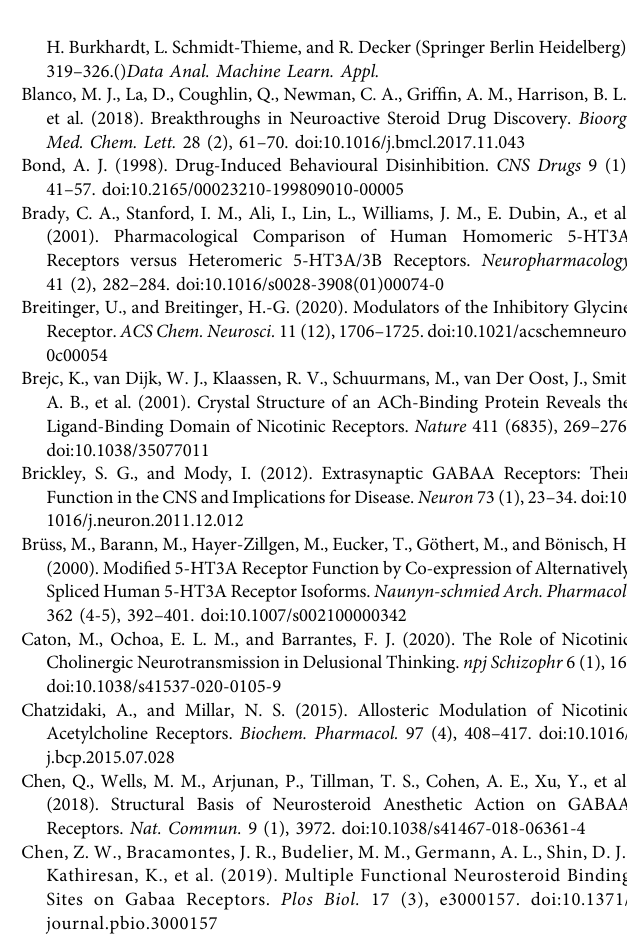
Supplementary Table S2 | Structures used for the pharmacophore